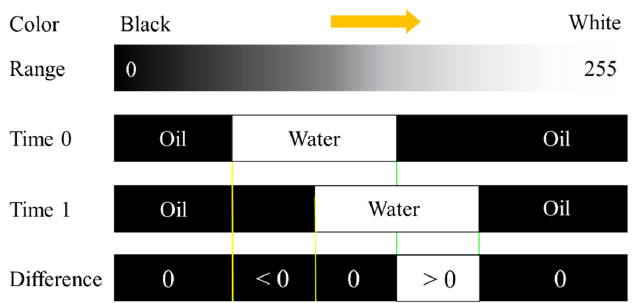
Figure 11. Schematic diagram of interframe di ff erence method.